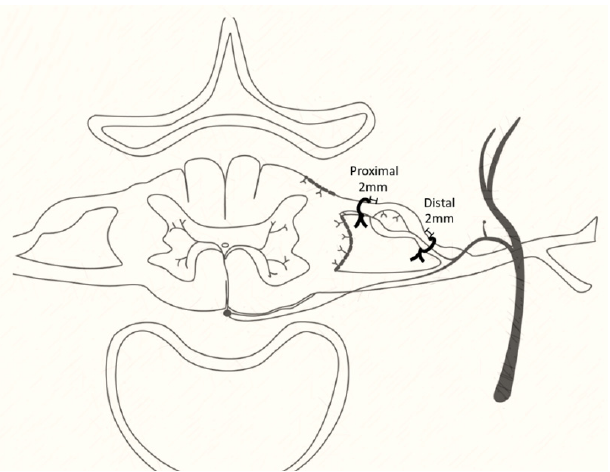
Figure 1. The animal models of lumbar radiculopathy. The 4-0 silk constrictions were applied 2 mm distal to the dorsal root ganglion of the L5 nerve root in animals with distal nerve constriction and 2 mm proximal in those with proximal nerve constriction.